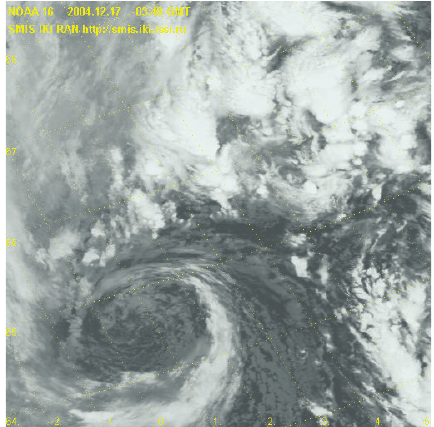
Figure 6: The fragment of regional cloud cover distribution data over the part of Norwegian Sea, derived from the results of satellite radiometer monitoring of the Earth’s atmosphere, obtained on December 17, 2004 at 03:40 GMT. Geographical coordinates are depicted on the horizontal and vertical